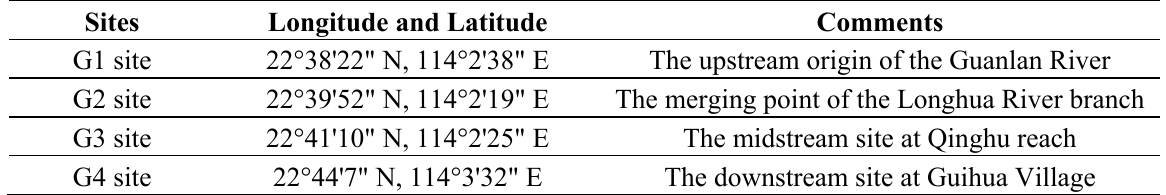
Table 1. Sampling sites in